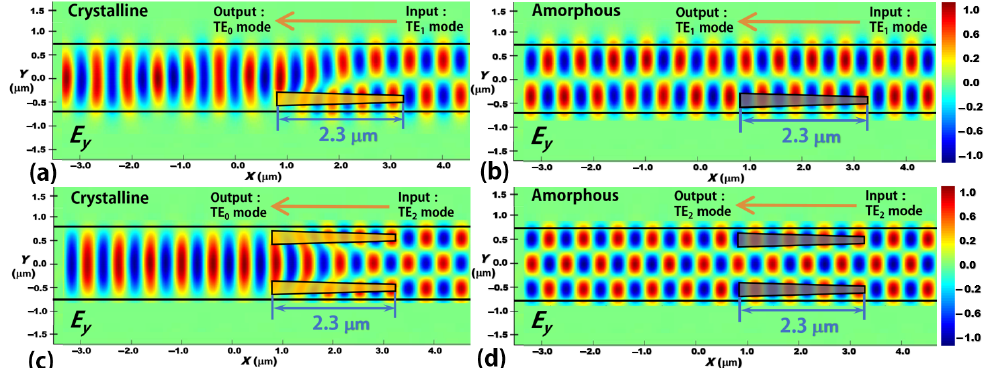
Figure 12. Backward transmission processes of the proposed reconfigurable mode converters. Evo- lutions of the electric field (dominant component: E y ) along the propagation direction ( x -direction) through the reconfigurable TE 1 -to-TE 0 mode converter, when the Sb 2 Se 3 layer working at ( a ) the crystalline state and ( b ) the amorphous state, respectively. Evolutions of the electric field (dominant component: E y ) along the propagation direction ( x -direction) through the reconfigurable TE 2 -to-TE 0 mode converter, when the Sb 2 Se 3 layer working at ( c ) the crystalline state and ( d ) the amorphous state, respectively.